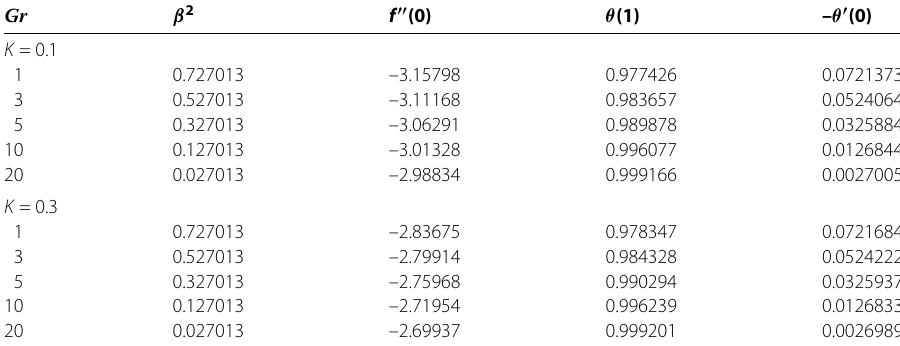
Table 7 Variation of β 2 = ϒ , f (cid:2)(cid:2) (0), θ (1) and – θ (cid:2) (0) using 20th-order HAM via Mathematica package BVPh2.0 approximation when Ma = 1, M = 1, Pr = 0.2, S = 0.2 and Gr is